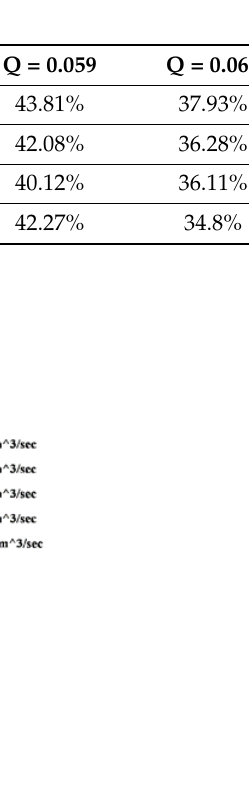
Figure 14. Graphical view of total energy dissipation.